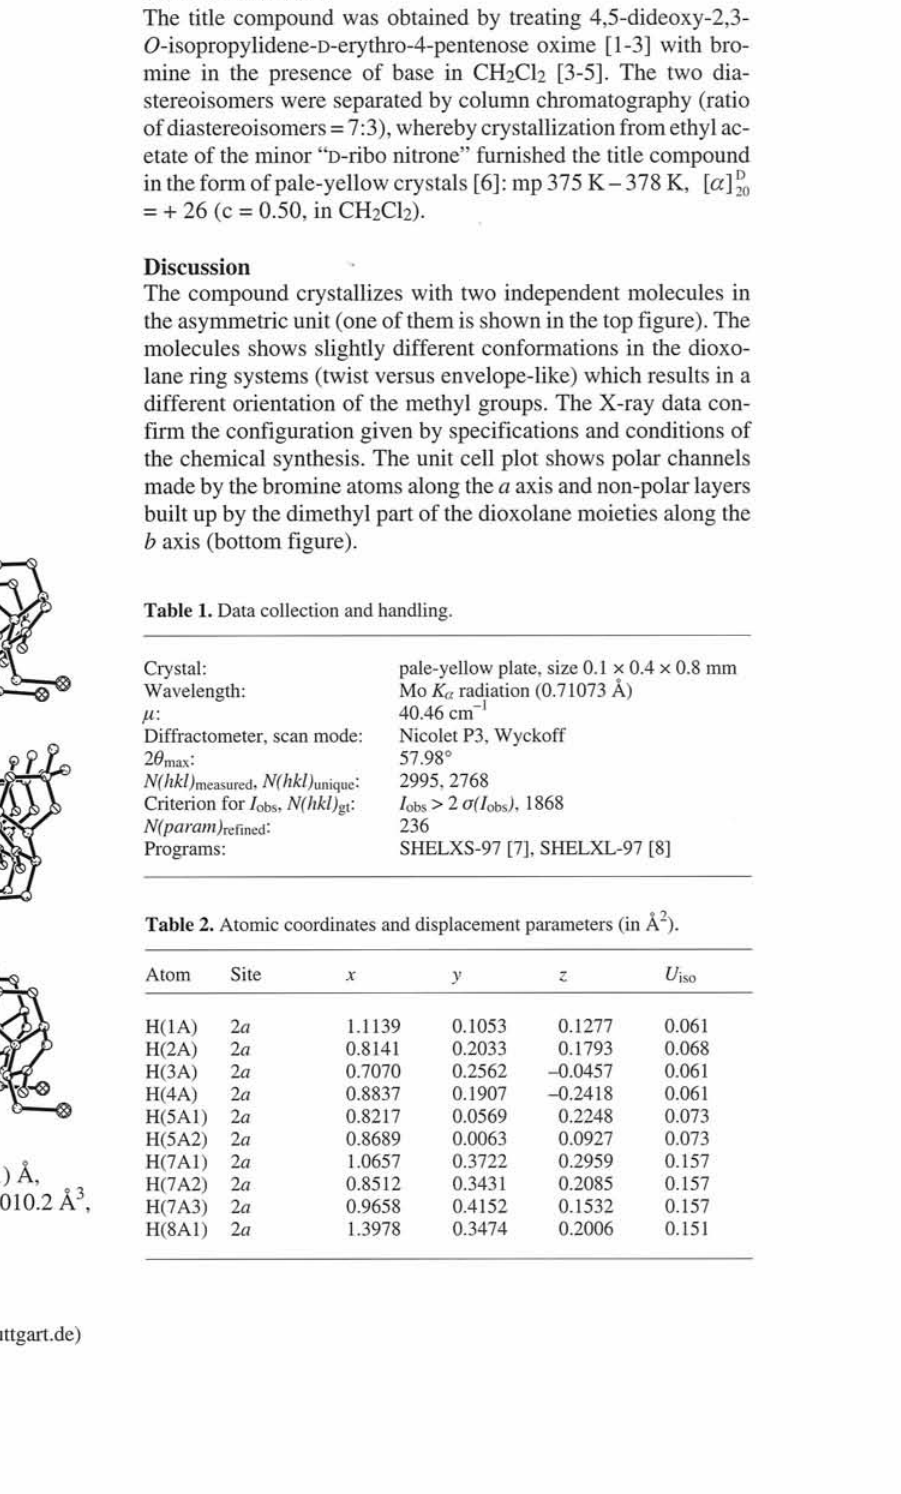
Table 2. Atomic coordinates and displacement parameters (in A